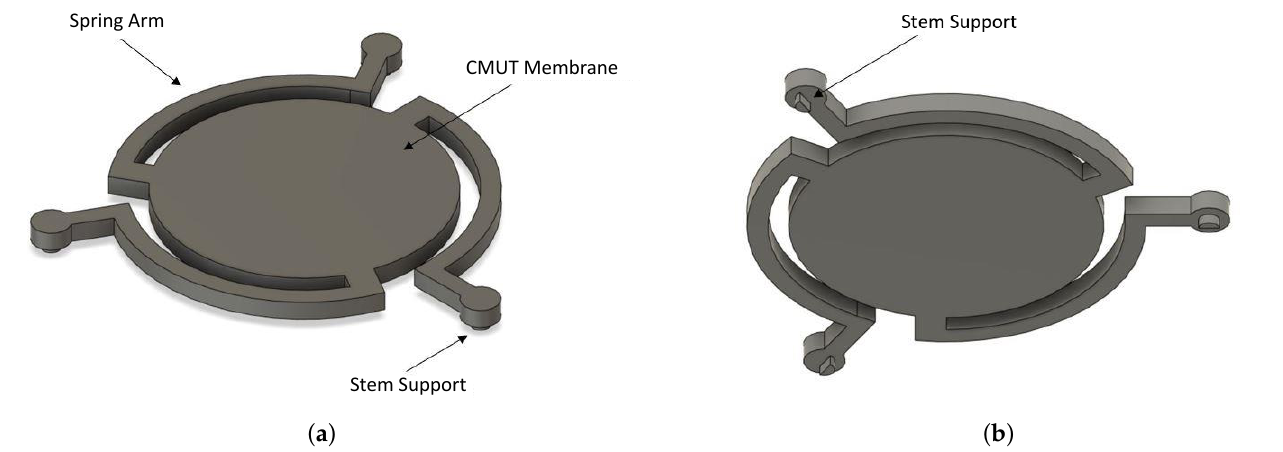
Figure 2. 3D CAD of the designed CMUT A and B. ( a ) Top view; ( b ) bottom